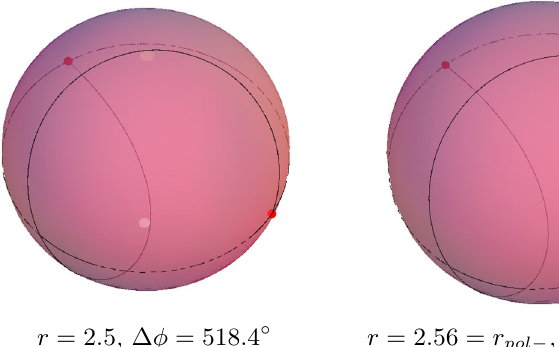
Fig. 11 Demonstration of the 4 π jump drop in value of the (cid:4)φ func- tion when overpassing the discontinuity point at r = r pol − in case of the Kerr BH with the spin parameter a = 0 . 9 (see Fig. 6a). In general, the SPOs are globally prograde at r < r pol − and globally retrograde